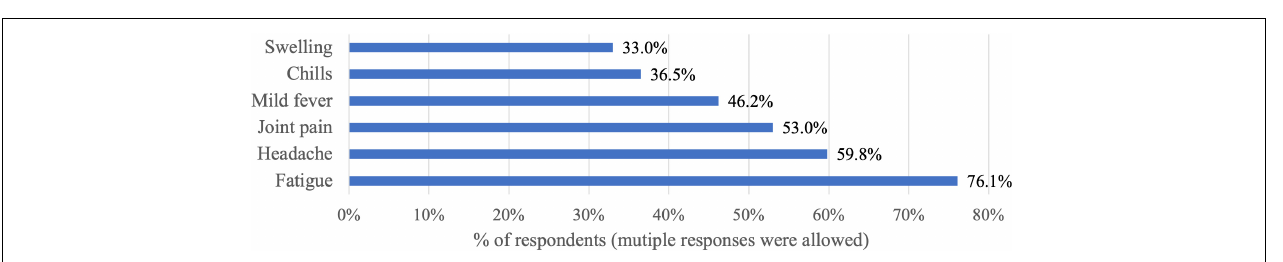
FIGURE 2 | The main stated adverse reactions after receiving the COVID-19 vaccine ( n =